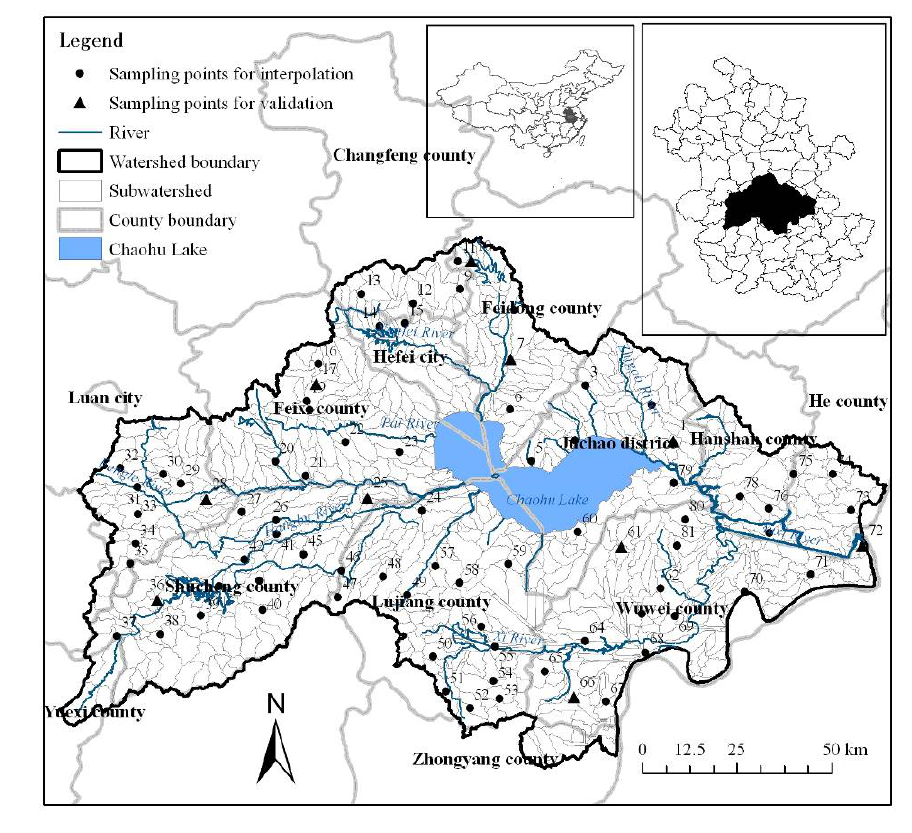
Figure 1. Location of the Chaohu Lake watershed in Anhui Province, China and the sampling sites of surface soil available phosphorous and subwatersheds in the Chaohu Lake